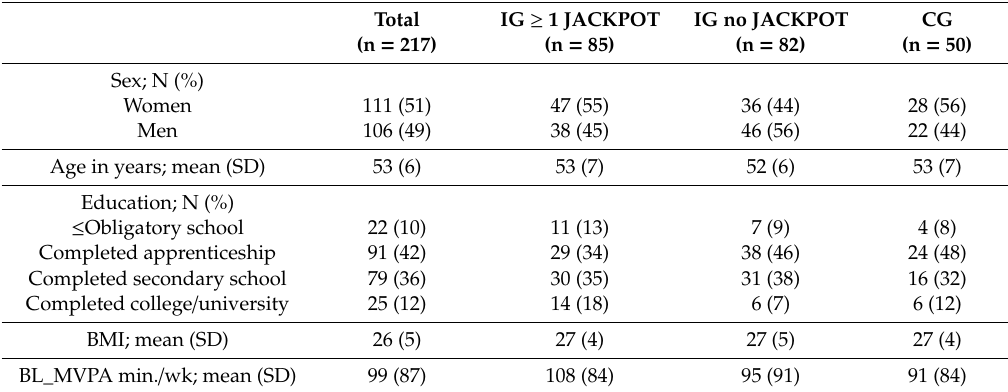
Table 1. Characteristics of participants with at least two accelerometer measurements (baseline (BL) and four or 12 months